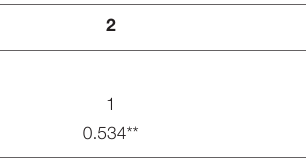
TABLE 3 | Pearson correlation among job satisfaction, social support and job